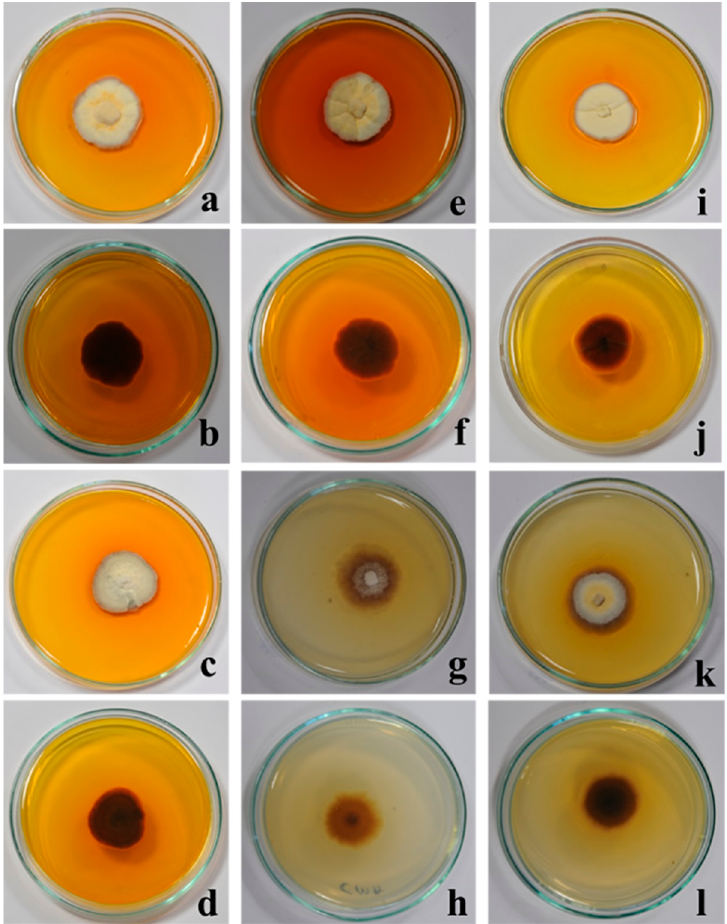
Figure 3. Studies on pigment production by G. triuniae (NFCCI 4873) on different media: ( a , b ) G. triuniae on PDA (front and reverse view); ( c , d ) G. triuniae on PCA (front and reverse view); ( e , f ) G. triuniae on SDA (front and reverse view); ( g , h ) G. triuniae on CMA (front and reverse view); ( I , j ) G. triuniae on CYA (front and reverse view; and ( k , l ) G. triuniae on CZA (front and reverse view).